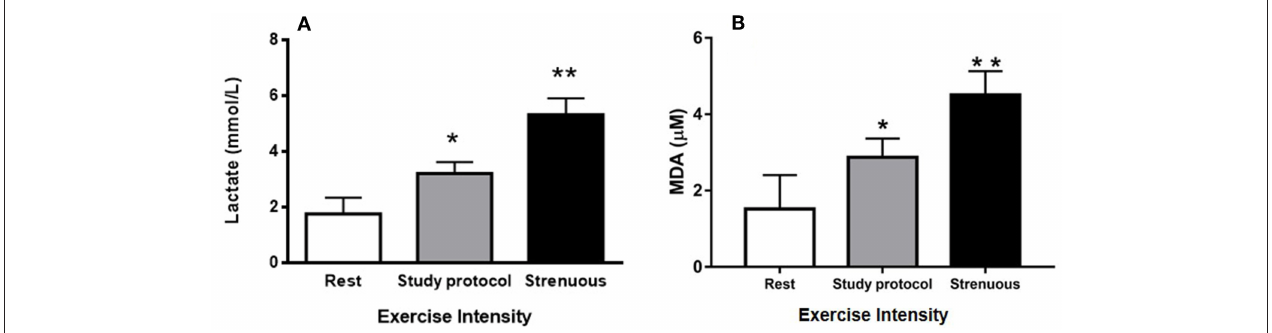
FIGURE 1 | Control of exercise intensity [blood lactate concentrations (A) and TBARs (B) ]: (A) Blood lactate concentrations were measured at rest as well as after a session of study protocol and intense exercise. (B) MDA concentrations (lipid peroxidation) were measured at rest as well as after a session of study protocol and intense exercise. The animals used in these dosages, lactate ( n = 15) and lipid peroxidation ( n = 15), did not participate of the experimental groups. (* P < 0.01 compared to rest, ** P < 0.001 compared to rest and study protocol). Values are expressed as mean and ± SD. Data were analyzed by one-way ANOVA followed by Tukey’s multiple comparison test.